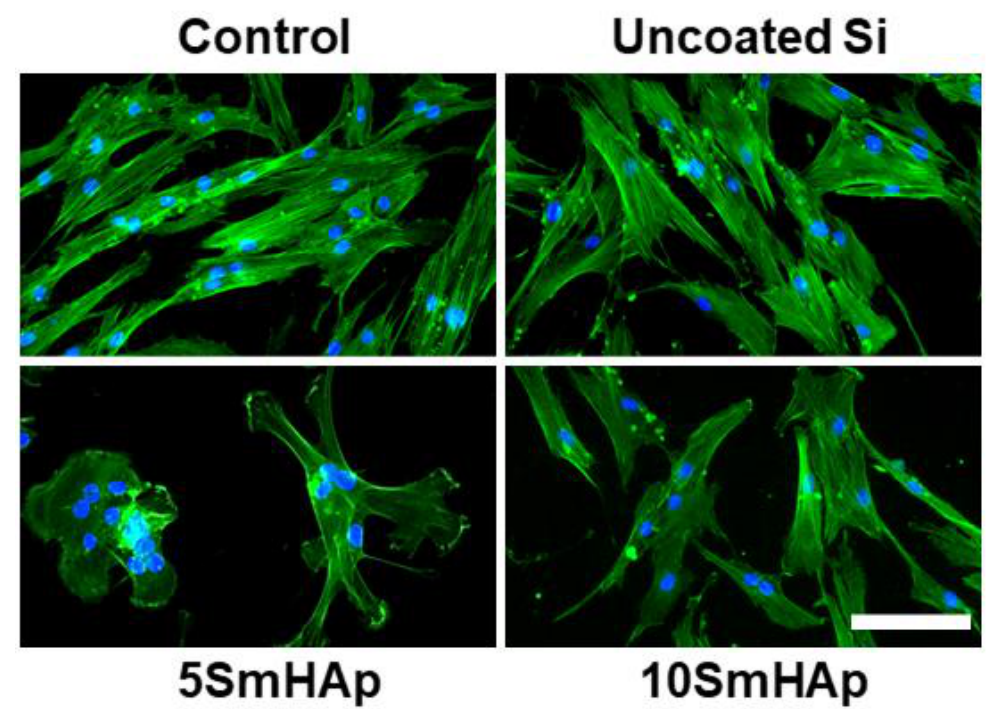
Figure 8. Actin cytoskeleton organization of gingival fibroblast cells after 24 h of incubation with uncoated Si substrates and different samarium doped hydroxyapatite coatings. F-actin (green) was labeled with phalloidin-phalloidin-fluorescein isothiocyanate (FITC) and nuclei (blue) were counterstained with 4′,6-diamidino-2-phenylindole dihydrochloride (DAPI). Scale bar: 20 µm.